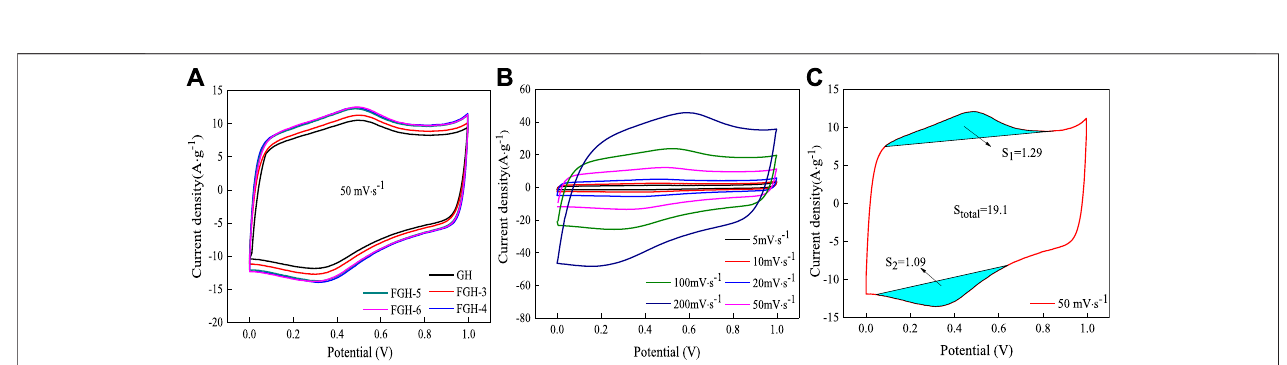
FIGURE 5 | The CV curves for the samples in 1 M H 2 SO 4 : (A) different samples at a scan rate of 50 mV/s, (B) FGH-4 at different scan rates, and (C) the CV split graph of FGH-4 at a scan rate of 50 mV/s.